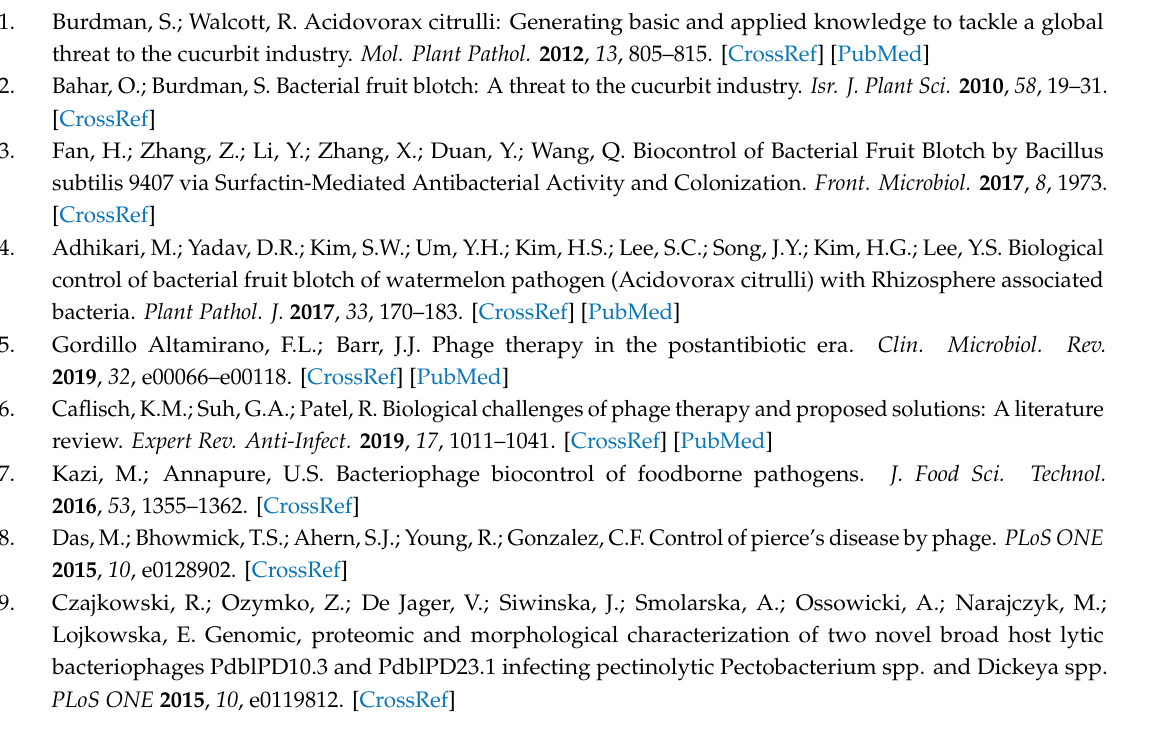
Figure S1: Stability of phage ACPWH in soil and melon extract. Phage ACPWH was added to soil at an initial titer of 3.3 × 10 7 PFU / g